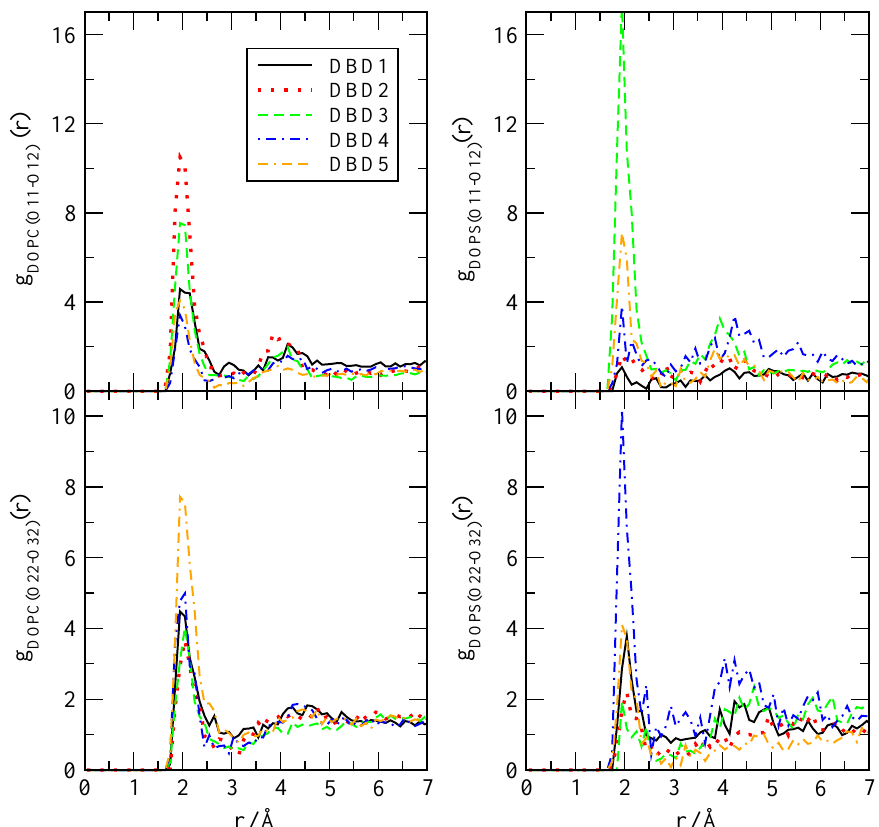
Figure 4. Radial distribution functions between site ‘H4’ of DBD derivatives and selected oxygen sites in DOPC and DOPS